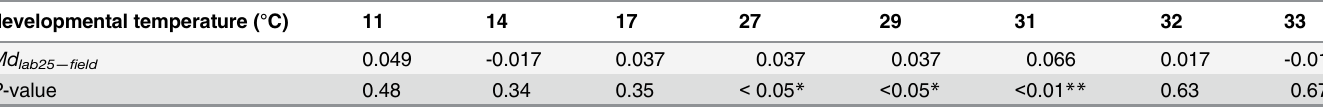
Table 2. Egg-to-adult viability